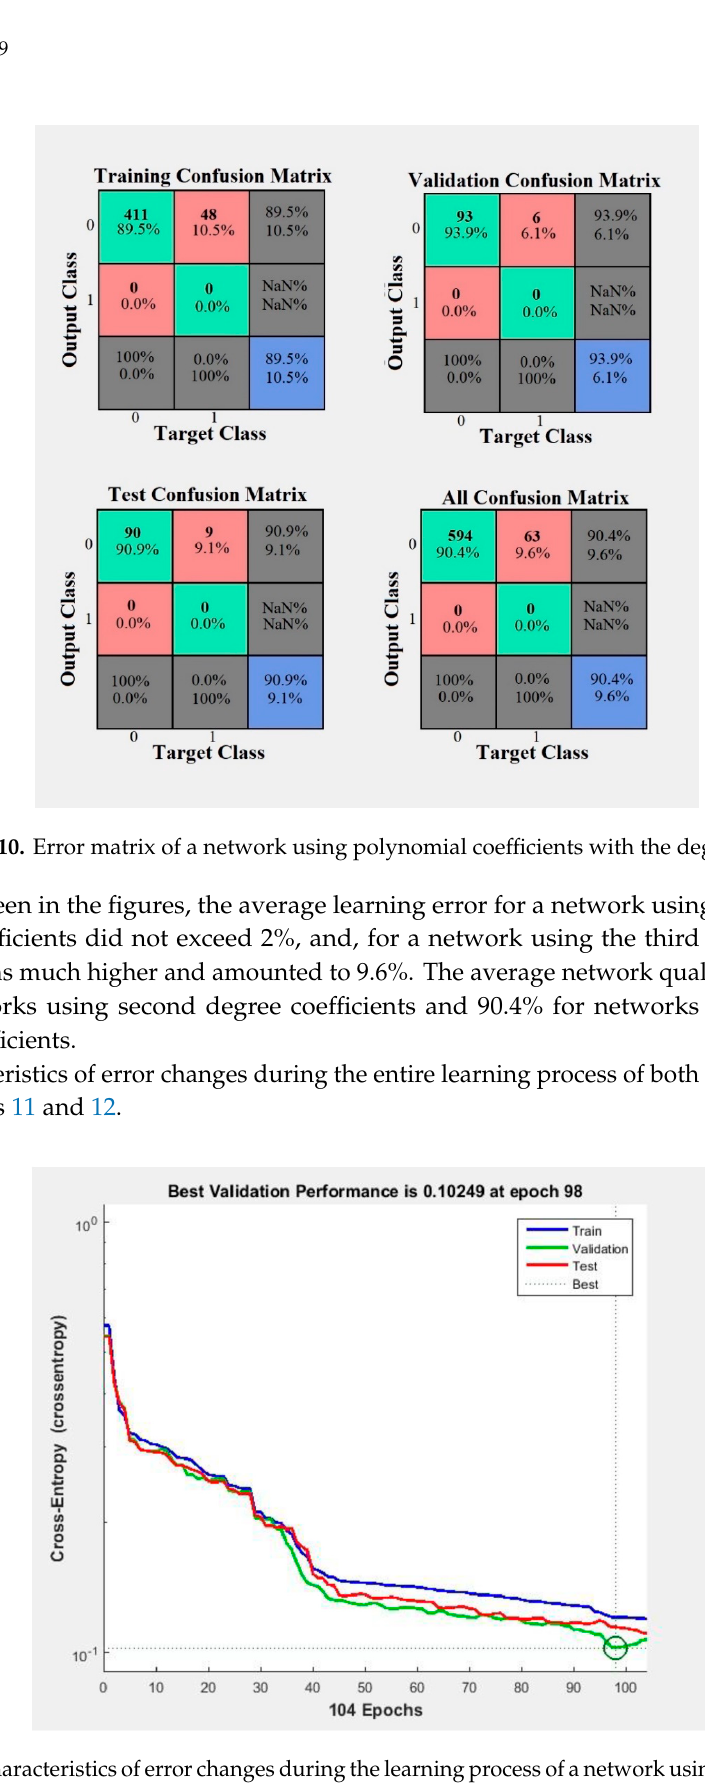
Figure 9. Error matrix of a network using polynomial coefficients with the degree N = 2.